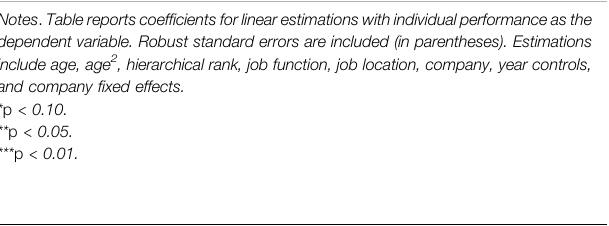
TABLE 7 | Random-effects and ordinary least squares regression results for within-ranks effects for men. Individual performance